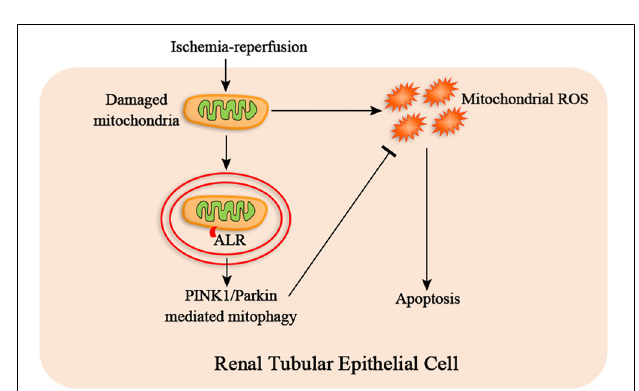
FIGURE 9 | The hypothetical mechanism of protective effect of augmenter of liver regeneration (ALR) in ischemia–reperfusion (I/R)–acute kidney injury (AKI) in vitro . I/R causes the mitochondrial damage of renal tubular epithelial cells, which induces mitochondrial reactive oxygen species (ROS) and apoptosis. ALR may protect renal tubular epithelial cells from apoptosis via PINK1/Parkin-mediated mitophagy, which remove the damaged mitochondria and reduce mitochondrial ROS